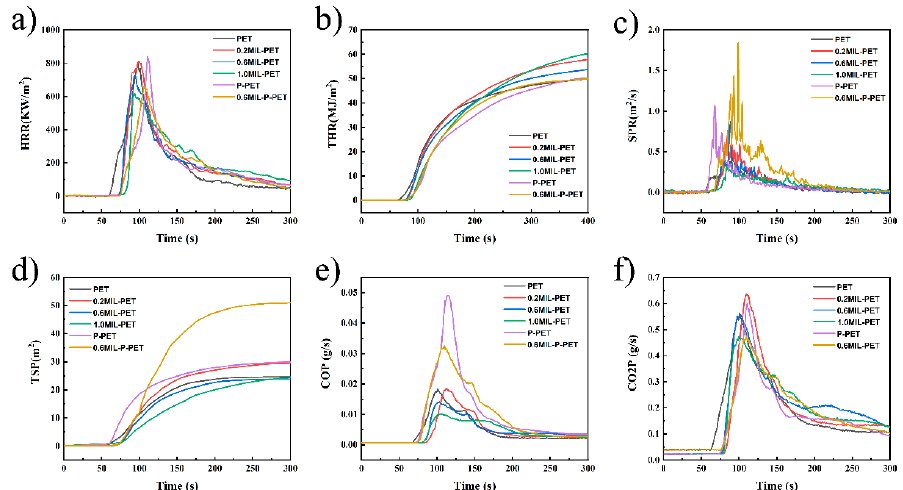
Figure 4. ( a ) Heat release rate (HRR), ( b ) total heat release (THR), ( c ) smoke production rate (SPR), ( d ) total smoke production (TSP), ( e ) carbon monoxide production (COP), and ( f ) carbon dioxide production (CO2P) curves of PET, 0.2MIL − PET, 0.6MIL − PET, P − PET, 0.6MIL − P − PET. Table 4. CC results of MIL-PET and MIL-P-PET